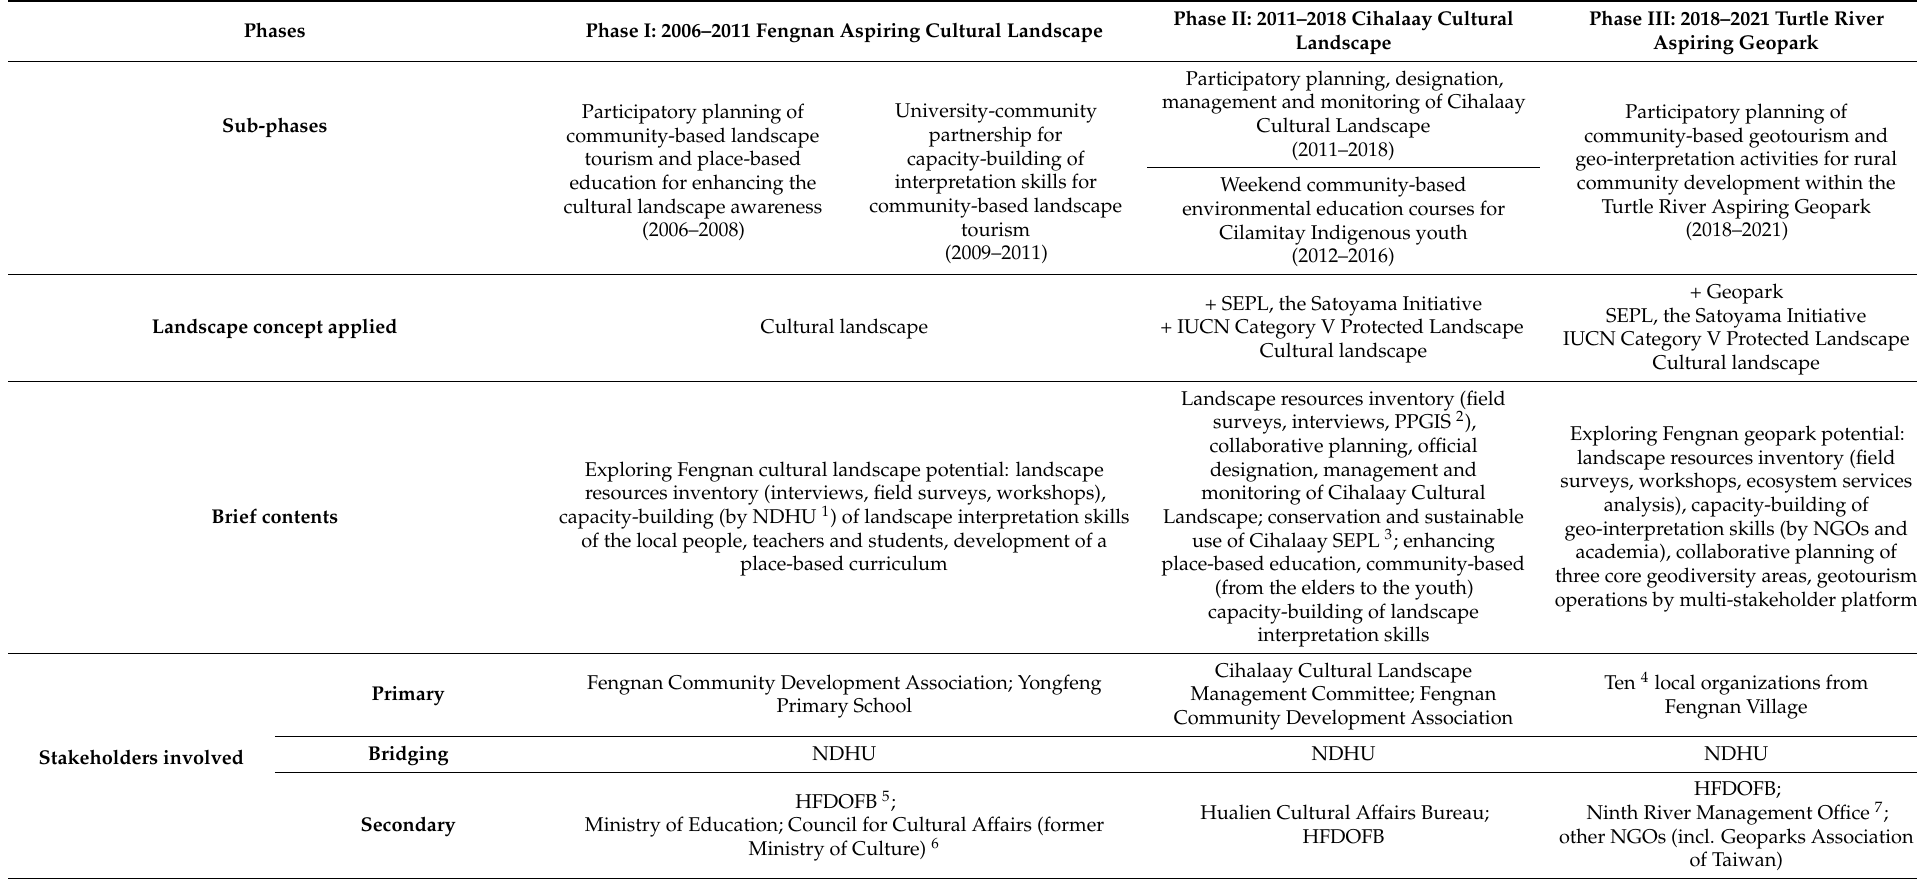
Table 1. Three phases of integrated landscape management for community-based landscape tourism in Fengnan Village, Hualien County, Taiwan